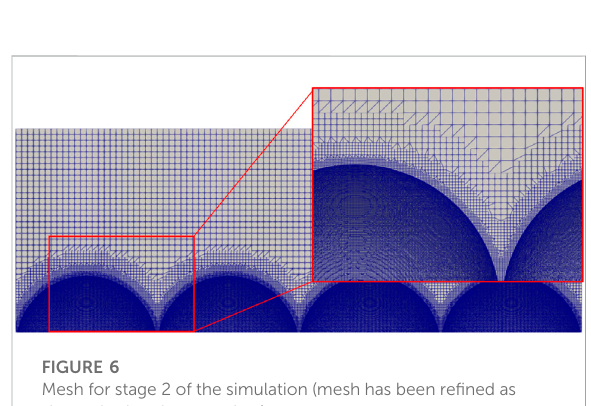
FIGURE 6 Mesh for stage 2 of the simulation (mesh has been re fi ned as shown in the close up